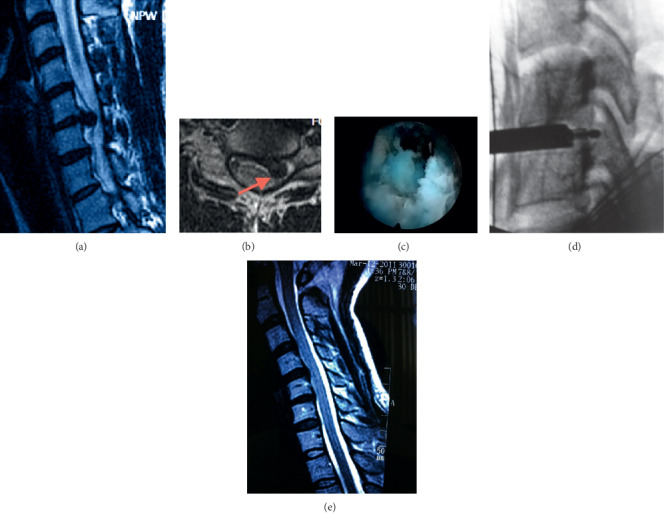
(a) T2-weighted sagittal magnetic resonance image (MRI) shows a central herniated disc at the level of C5-C6. (b) The axial MRI scan shows the herniated disc compresses the left spinal cord and nerve root. (c) The herniated disc was visible under endoscopy. (d) Fluoroscopy shows that the working cannula has been satisfactorily placed at the C5-C6 disc. (e) Sagittal MRI after ATd-PECD shows a removal of the protruded nucleus pulposus.